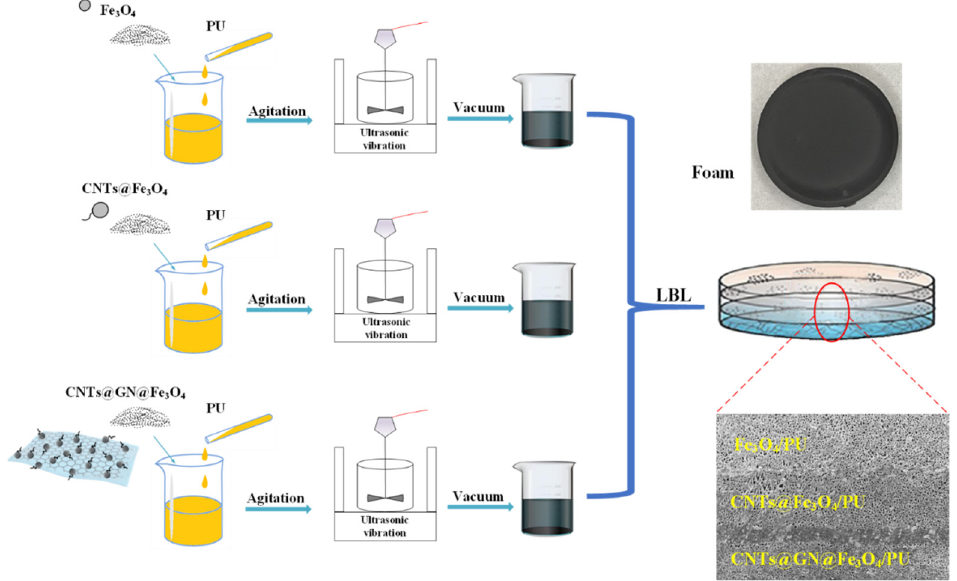
Figure 2. Preparation of three-layer